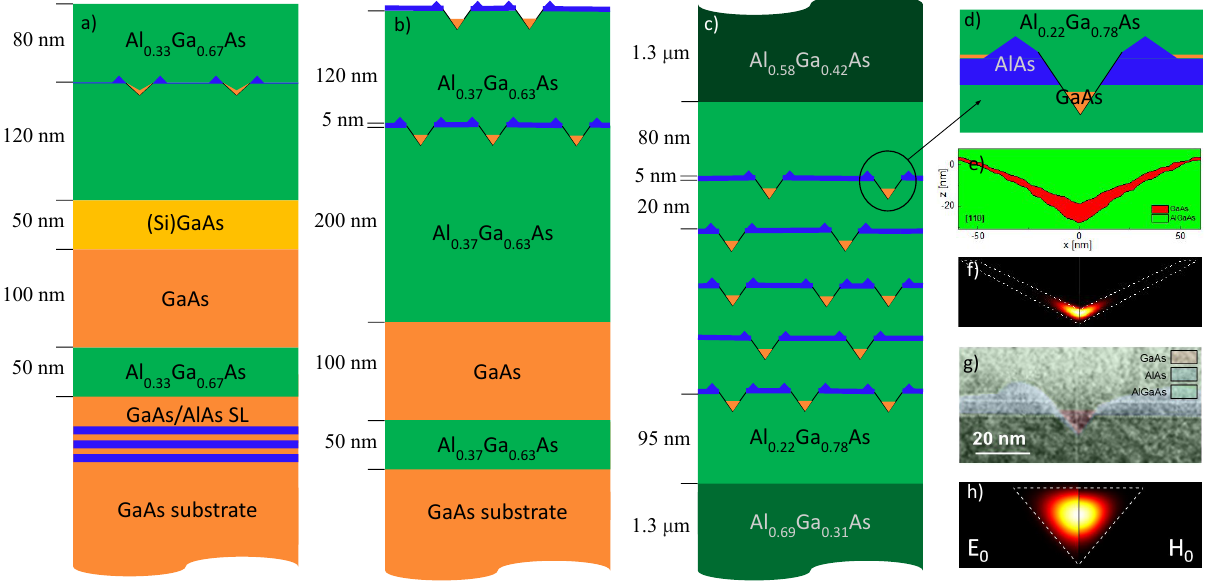
Figure 1. Cross-section schematics of samples ( a ) type I, ( b ) type II and ( c ) type III; ( d ) magnified schematic of a single quantum dot (QD) of type III with surroundings; ( e ) atomic force microscopy (AFM) linescans of the central part of a type I GaAs V-shaped QD in AlGaAs from a sample series illustrating the different interfaces during QD fabrication [37,38]; ( f ) cross-sectional simulated probability densities of the electron E 0 (left) and hole H 0 (right) ground states in a V-shaped QD [37,38]; the simulations are performed using a finite-element approach basing on Schrödinger equation in effective-mass approximation; ( g ) cross-sectional transmission electron microscopy (TEM) image of a GaAs cone QD fabricated by filling a nanohole in AlAs/AlGaAs [36]; the color-coding of the materials is a guide for the eyes; ( h ) cross-sectional simulated probability densities in a cone